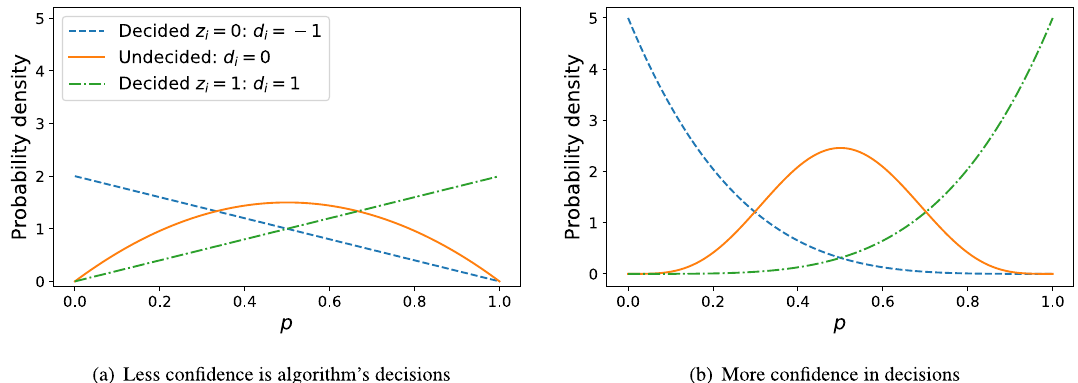
Figure 2. Example decision priors for when a researcher is ( a ) less confident in the allocation method’s decisions, ( b ) more confident in the